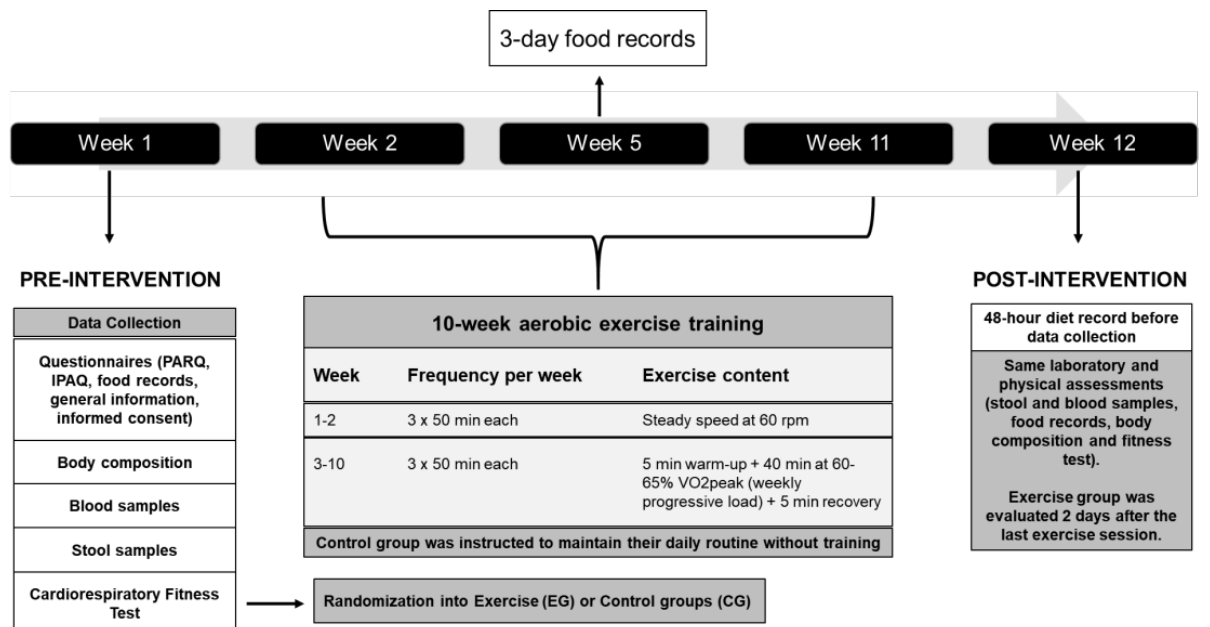
Figure 2. Study design, measurements and exercise protocol. Legend: IPAQ: International Physical Activity Questionnaire; PARQ: Physical Activity Readiness Questionnaire; VO 2 peak: peak oxygen consumption; rpm: rotations per minute.